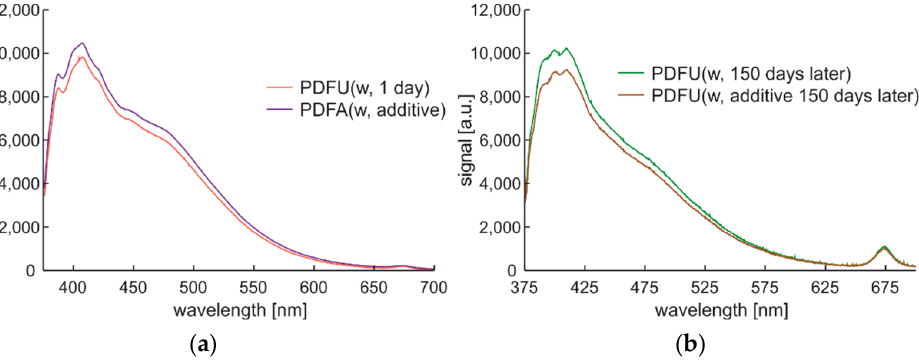
Figure 10. Complete spectral data of winter-type diesel stored in standard tank: ( a ) Stored one day and then examined; ( b ) unmodified premium diesel fuel stored for 150 days and then examined as PDFU (w, 150 days later) and after modification PDFU (w, additive 150 days later). The initial characteristics of one day of photodegradation are presented in Figure